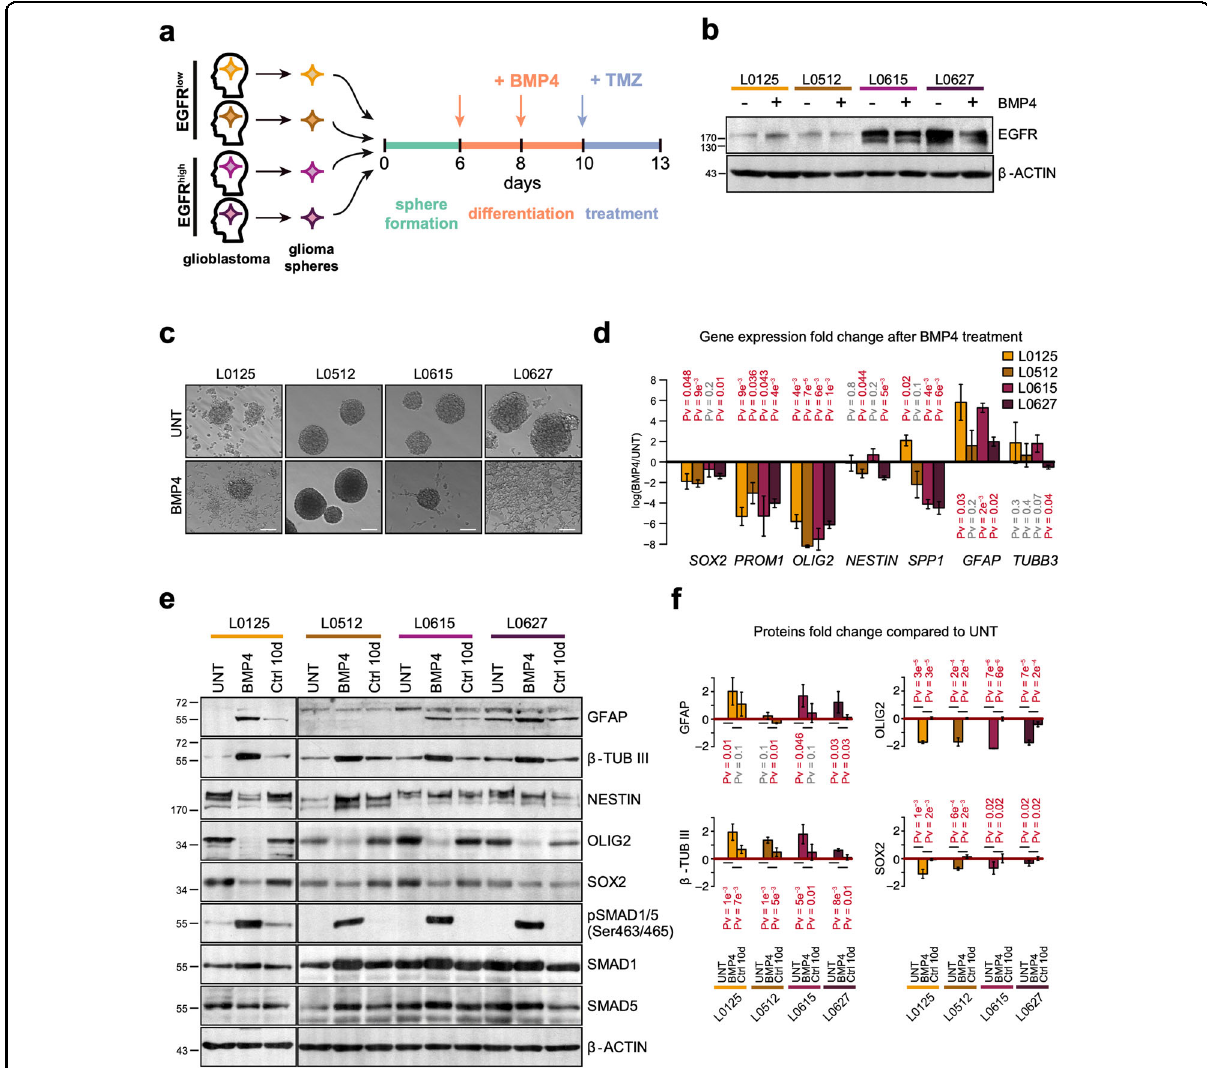
Fig. 1 BMP4 treatment promotes the differentiation of glioma spheres. a Experimental scheme of treatments. Red and blue arrows indicate BMP4 and TMZ treatments, respectively. b Western blot analysis of EGFR in untreated and BMP4-treated glioma spheres. β -actin was used as a loading control. c Microphotographs of untreated (upper row) and BMP4-treated (bottom row) glioma spheres. Different cell lines are shown in columns and are indicated above the photographs. Scale bars represent 100 μ m. d Quantitative PCR analysis of pluripotency markers ( SOX2, PROM1, OLIG2, NESTIN , and SPP1 ) and differentiation markers ( GFAP and TUBB3 ) in untreated and BMP4-treated glioma spheres. The results are presented as fold change in a log-scale. Gene expression in BMP4-treated cells was compared to untreated cells; data are presented as the mean ± SD of